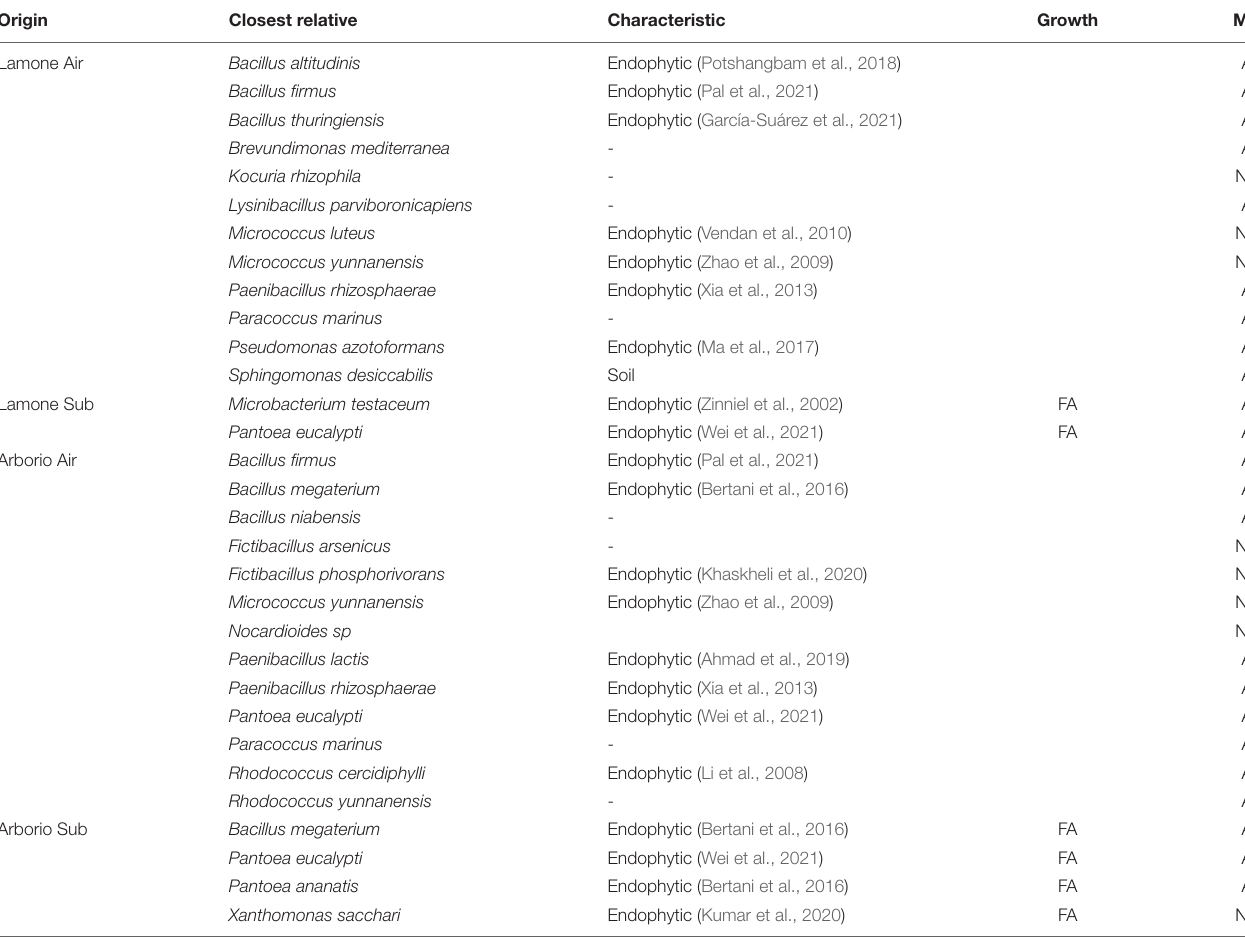
TABLE 1 | Putative bacterial endophytes isolated from Arborio and Lamone rice varieties at day 4 under dark air (Air) and submergence (Sub), and isolated under aerobic conditions.